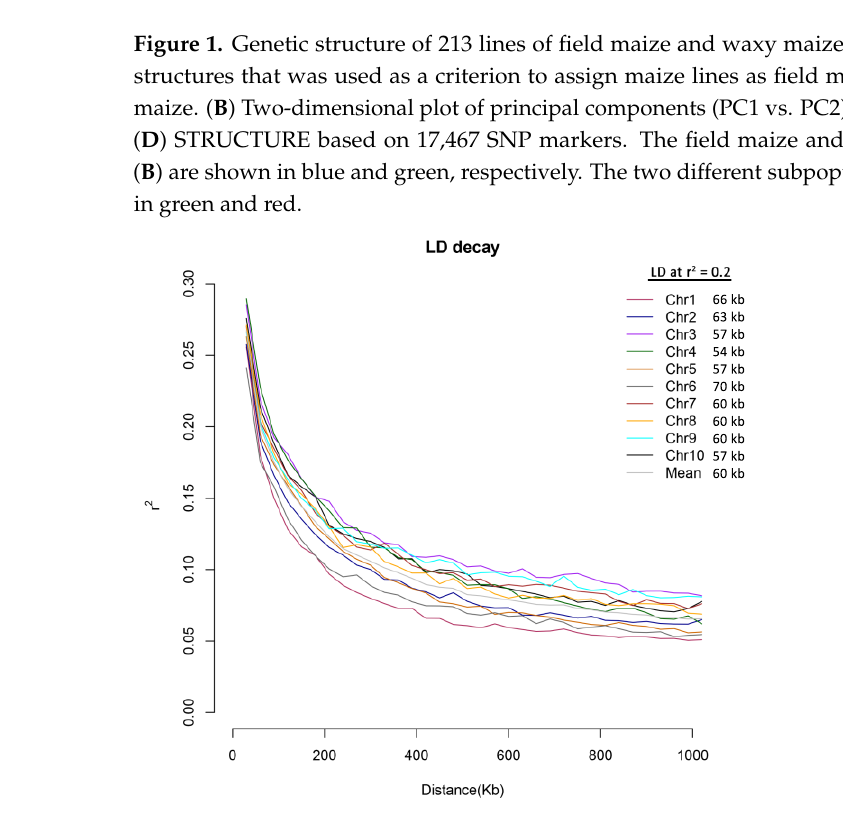
Figure 2. Overall chromosome-wide linkage disequilibrium (LD) decay estimated from 155,768 SNP genotypes of 213 maize lines. Each line plot represents a smoothed r 2 for all marker pairs on each chromosome depending on the distance between marker pairs.